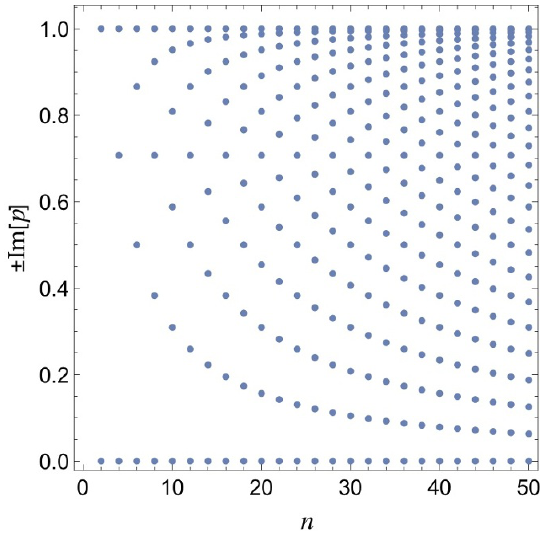
Figure 1 . The values of (cid:6) Im[ p ] predicted by the groups of (cid:1)(6 n 2 ) series for even n , and n (cid:20)